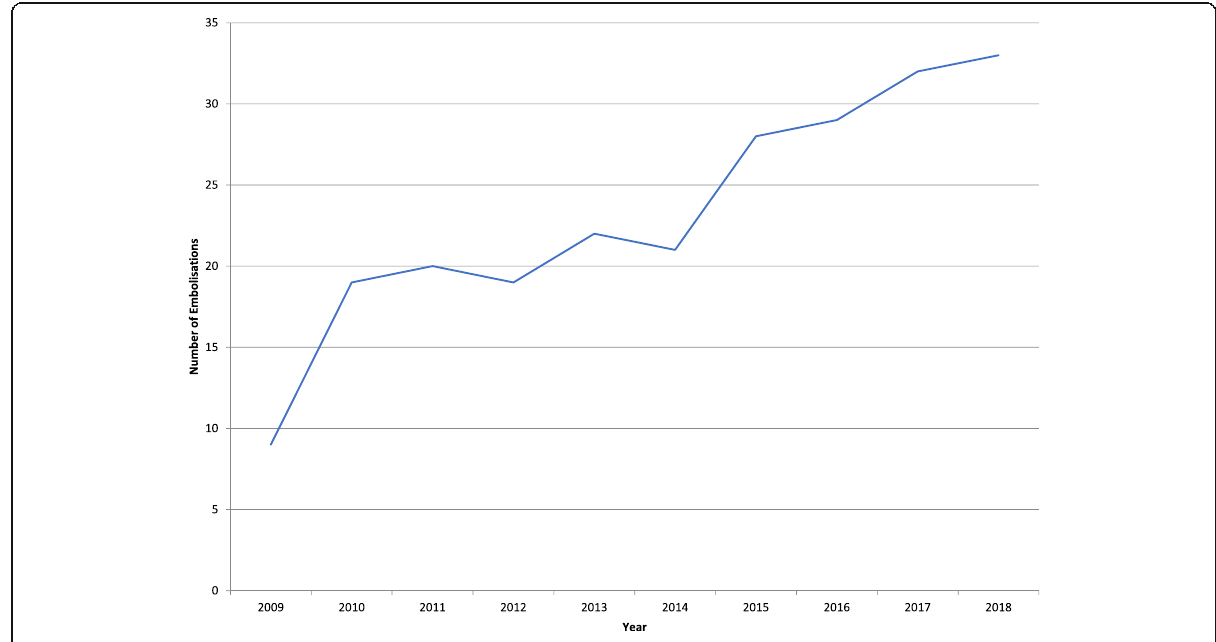
Fig. 3 Ten-year trend of increasing number of SAE procedures at our institution for blunt abdominal